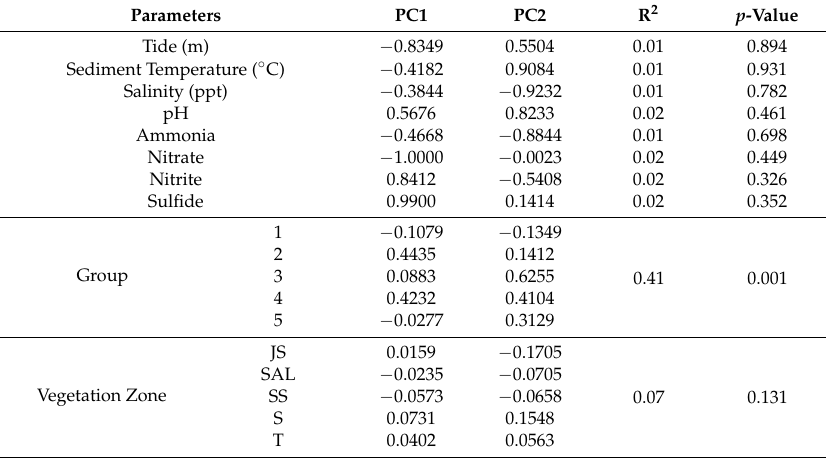
Table 1. Drivers of